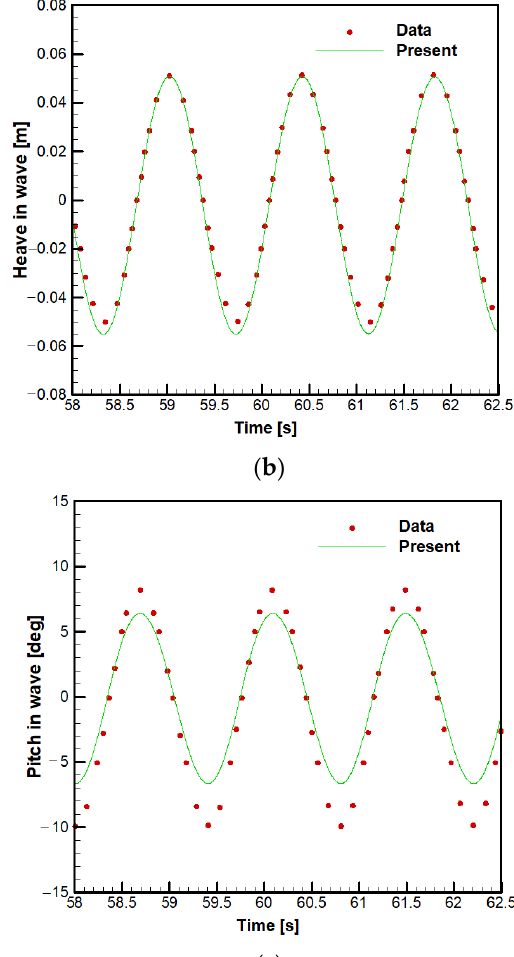
Figure 14. Moored motions in wave: ( a ) Moored surge motion in wave; ( b ) Moored heave motion in wave; ( c ) Moored pitch motion in wave.